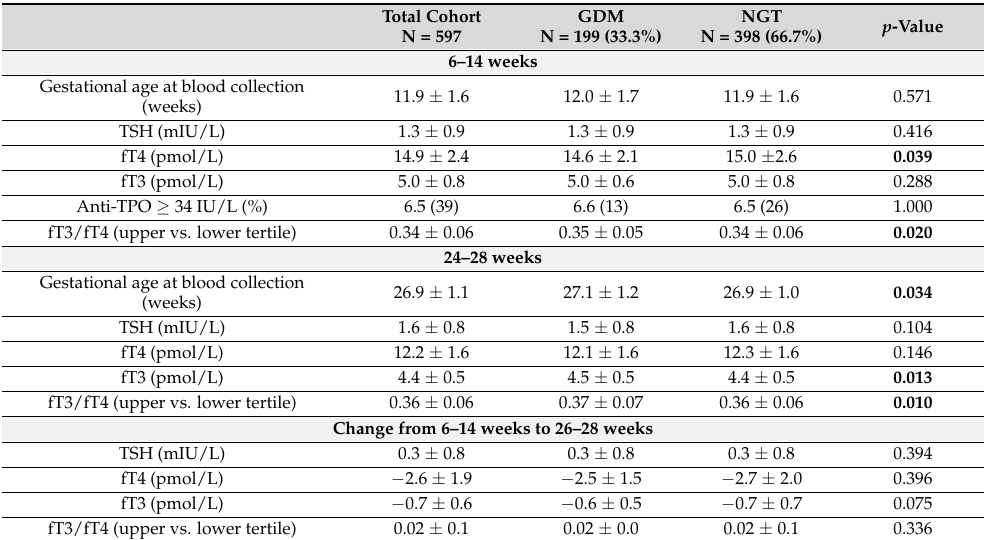
Table 1. Mean plasma concentrations of thyroid function markers in women with GDM and matched controls.